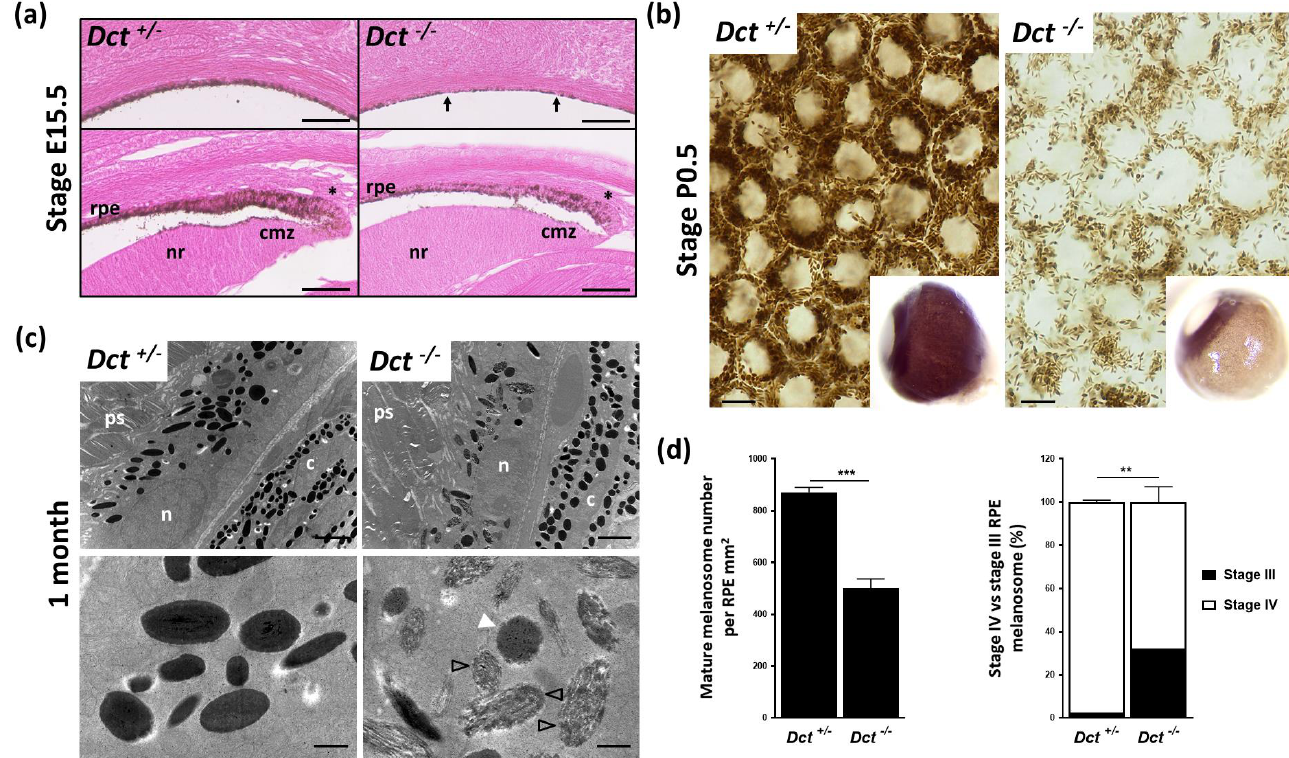
Figure 3. Defect in melanogenesis in the developing RPE of Dct − / − mice. ( a ) Eosin histology of the E15.5 eye showing the RPE in equatorial (upper panels) and anterior (lower panels) fields; scale bar: 50 µ m. Arrows point to unpigmented cells in the RPE of a Dct − / − embryo, whereas at the same stage, all RPE cells are pigmented in the control embryo; Asterisks indicate tip RPE cells with pigment granules located apically in both Dct − / − and control eyes; cmz, ciliary margin zone; nr, neural retina; ( b ) Bright-field microscopy of P0.5 RPE flat mounts showing a reduced number of pigment granules in Dct − / − samples, scale bar: 10 µ m. Inserts show whole eyeballs. At this stage, only the iris and RPE are pigmented in the wild-type, not the outer layer (choroid), so that hypopigmentation of the RPE can be readily detected on enucleated Dct − / − eyes; ( c ) Transmission electron microscopy of the RPE at 1 month. Low magnification (upper panels, scale bar: 2 µ m) shows no difference in the subcellular localization and the shape (round vs. elliptic) distribution of the melanosomes, but these are fewer and less electron-dense in Dct − / − RPE; c, choroid; n , RPE cell nucleus; ps, photoreceptor segment. High magnification (lower panels, scale bar: 500 nm) shows that most of the melanosomes in Dct − / − RPE are at stage III (black arrowheads) or stage IV but with irregular contours (white arrowhead) compared to the controls that are mostly stage IV and exhibit a smooth shape; ( d ) Quantification of mature melanosomes (left histogram) and stage IV vs. stage III melanosomes (right histogram) from representative sections of one eye per genotype. Total number of analyzed melanosomes: n > 2000 for Dct +/ − , n > 1000 for Dct − / − . Values are presented as means ± SEM. Means were compared using t -test, ** p < 0.01; *** p <